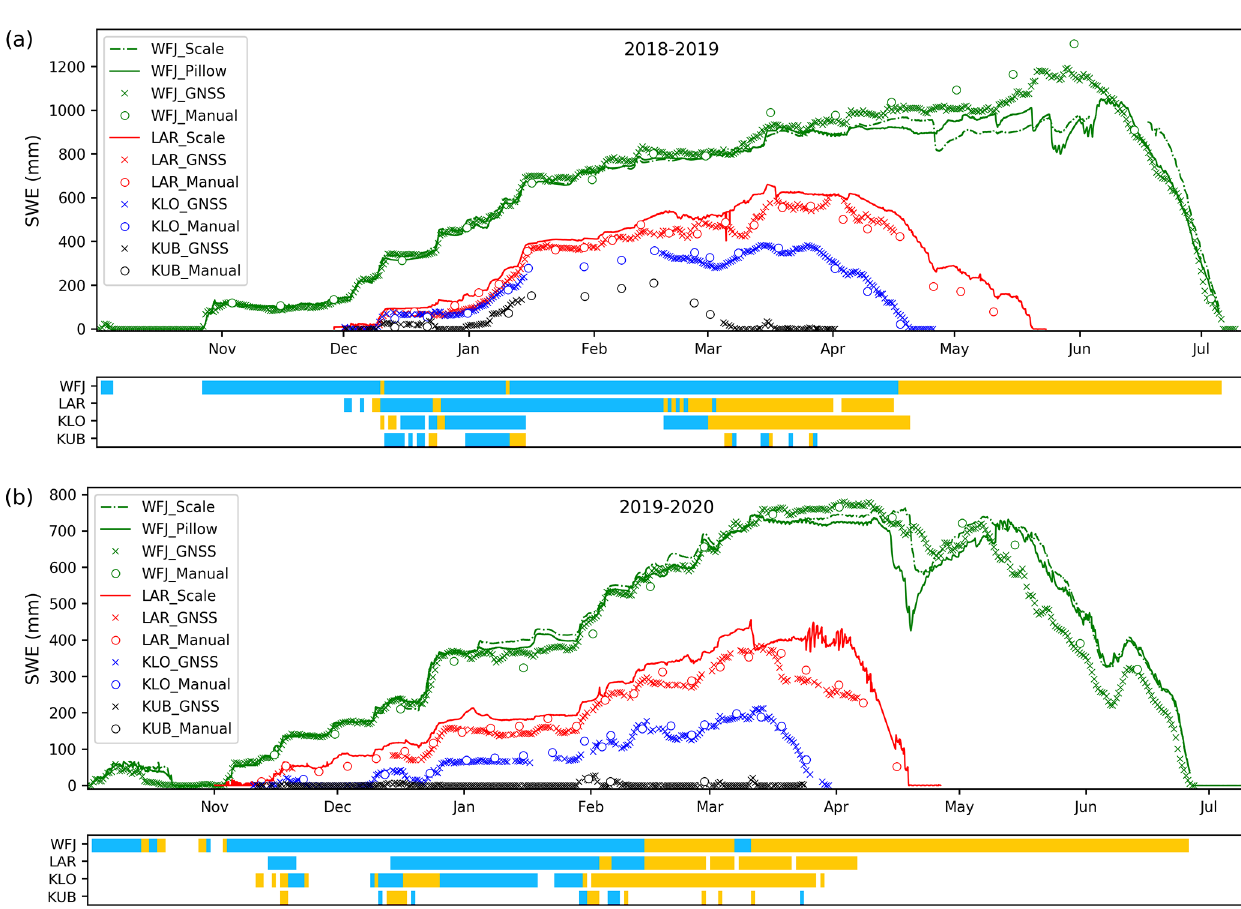
Figure 3. GNSS-derived SWE and reference data for (a) the 2018–2019 winter and (b) 2019–2020 winter for the sites Weissfluhjoch 2540ma.s.l. (WFJ), Laret 1510ma.s.l. (LAR), Klosters 1185ma.s.l. (KLO) and Küblis 820ma.s.l. (KUB). The color bars indicate whether the dry-snow (blue) or wet-snow (orange) GNSS algorithm was